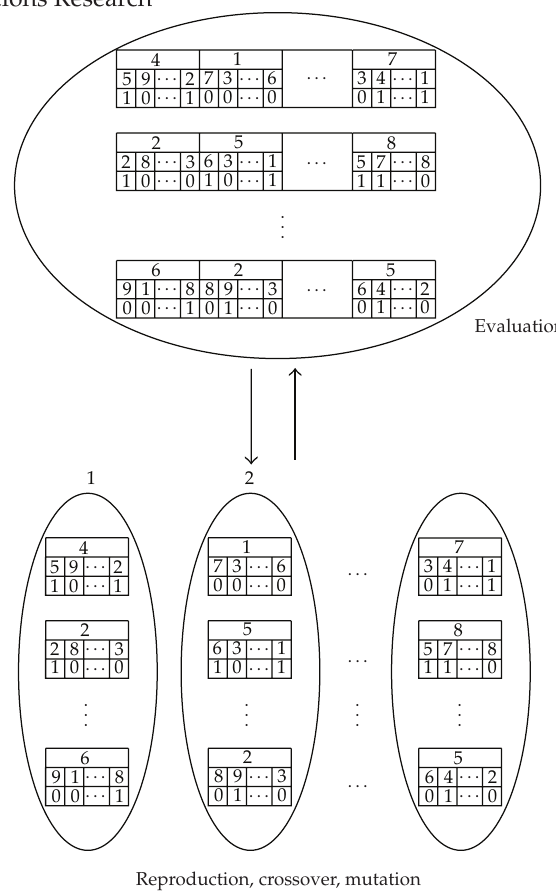
Figure 8: The outline of procedures.